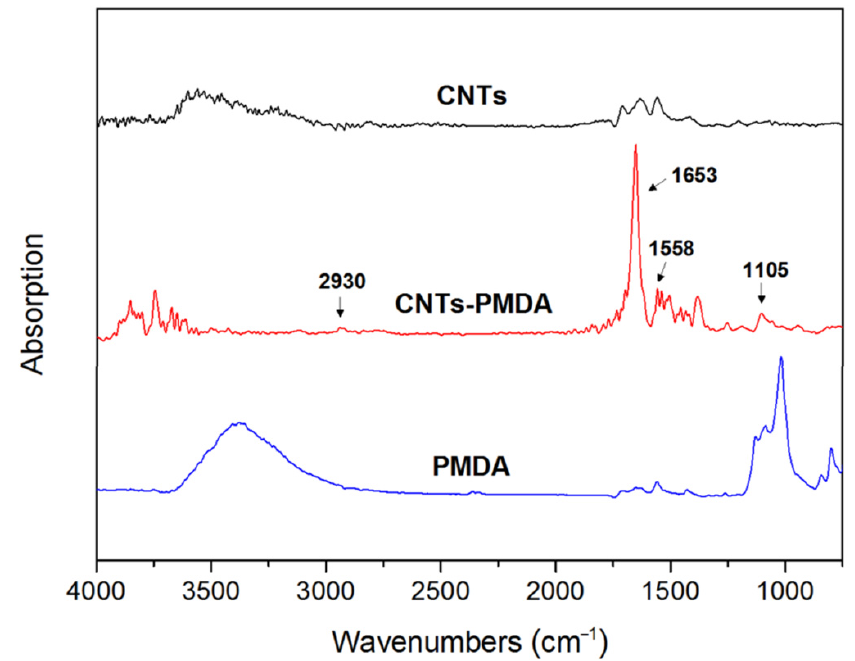
Figure 1. FTIR spectra of PMDA, CNTs and CNTs-PMDA.